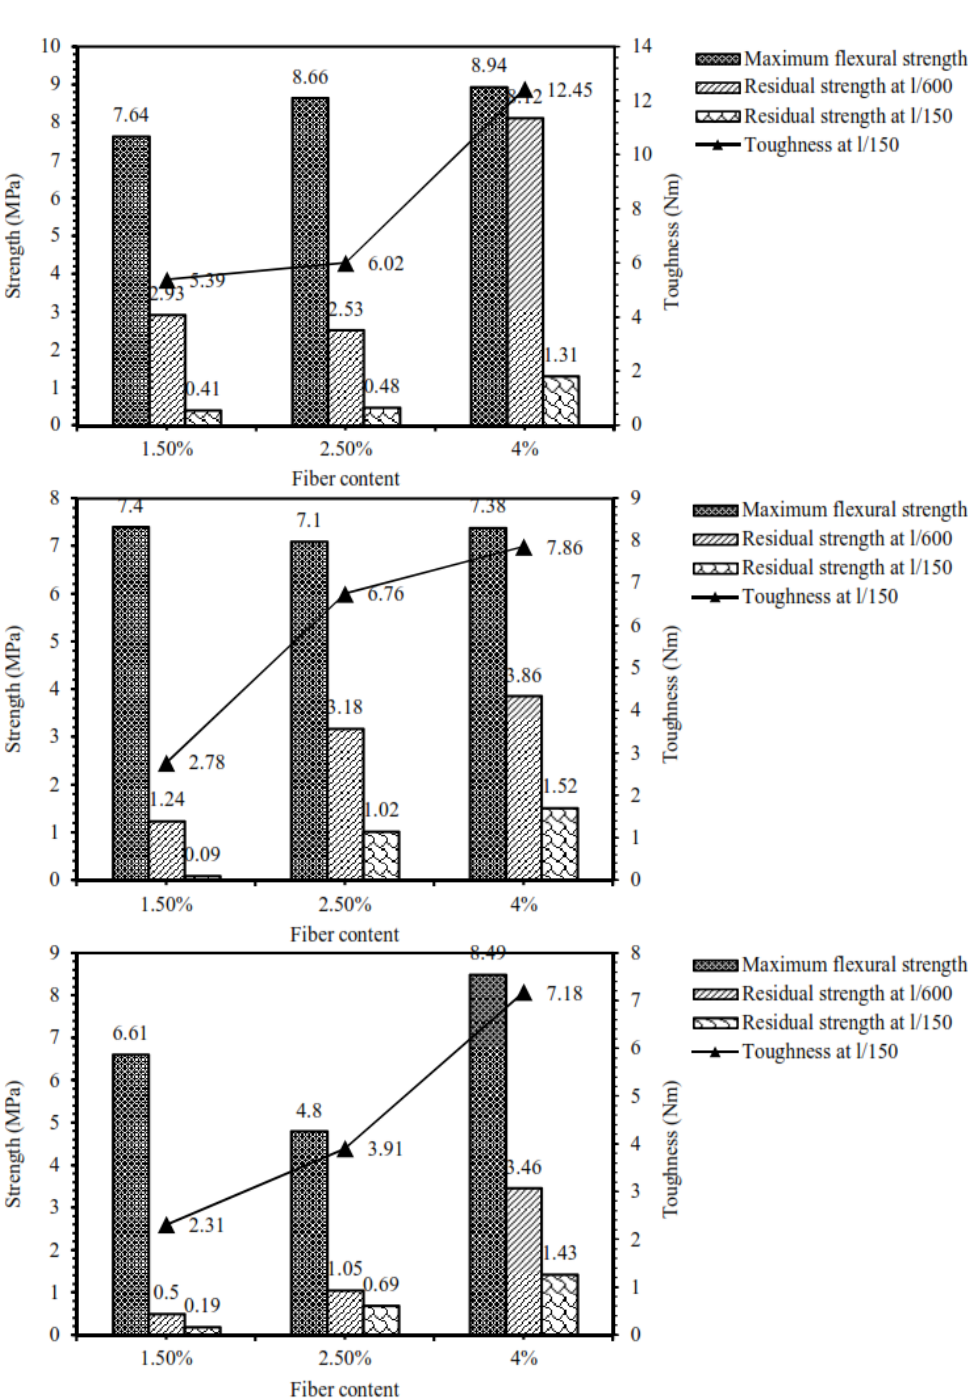
Figure 13: a) Several flexural strength parameters of HFRC specimens at different fiber content and 75%SF+25%PF proportion; b) Several flexural strength parameters of HFRC specimens at different fiber content and 50%SF+50%PF proportion; c) Several flexural strength parameters of HFRC specimens at different fiber content and 25%SF+75%PF